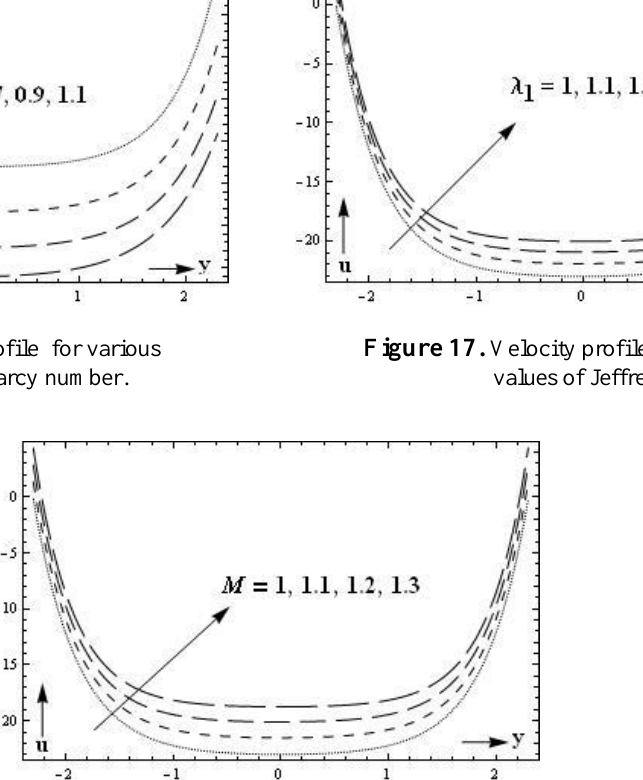
Figure 14. Velocity profile for various values of elastic parameters.